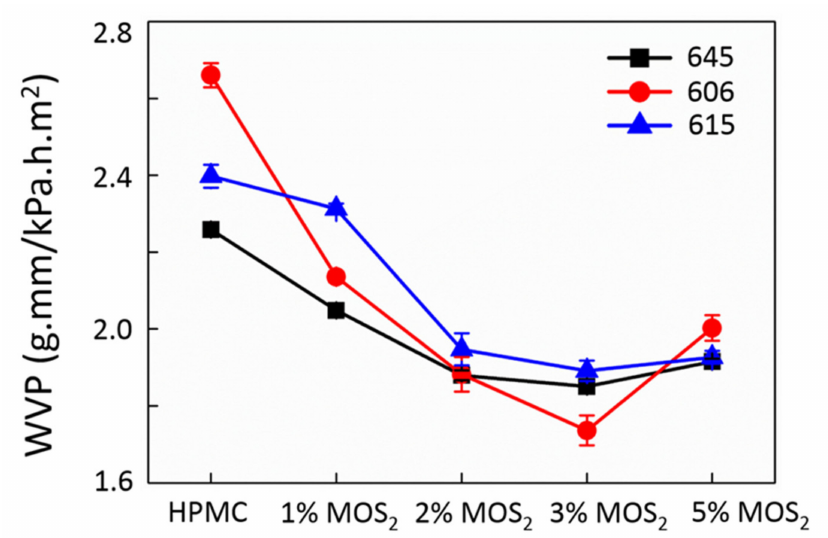
Figure 7. WVP of MoS 2 /HPMC composites.